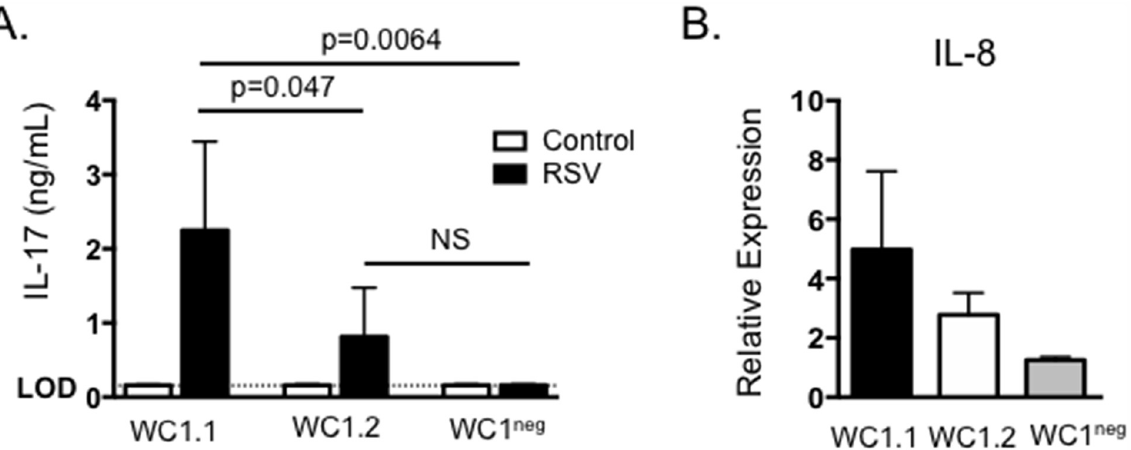
Fig 5. WC1.1 + γδ T cells produce IL-17 in response to BRSV. γδ T cells were purified from the peripheral blood of BRSV vaccinated or control animals by FACS based upon their expression of the γδ T cell receptor and either expression of WC1.1, WC1.2 or lack of WC1. Cells were cultured in the presence